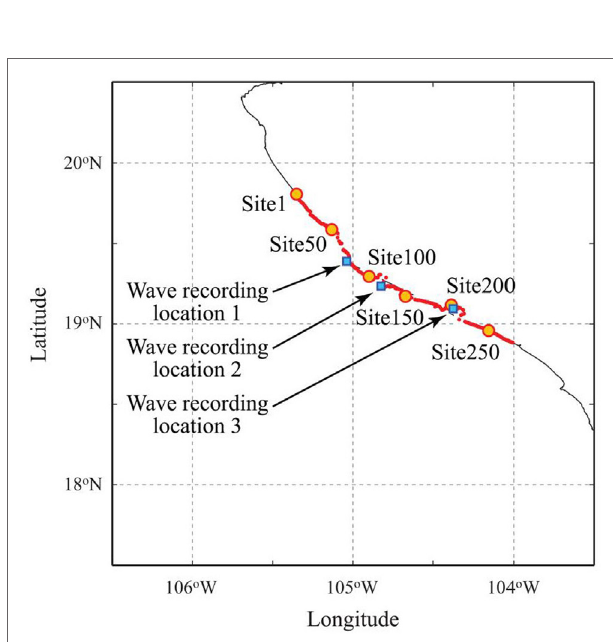
FigUre 11 | Site locations (1–284) and wave recording locations (1–3) for the analysis of time series of tsunami surface elevation.